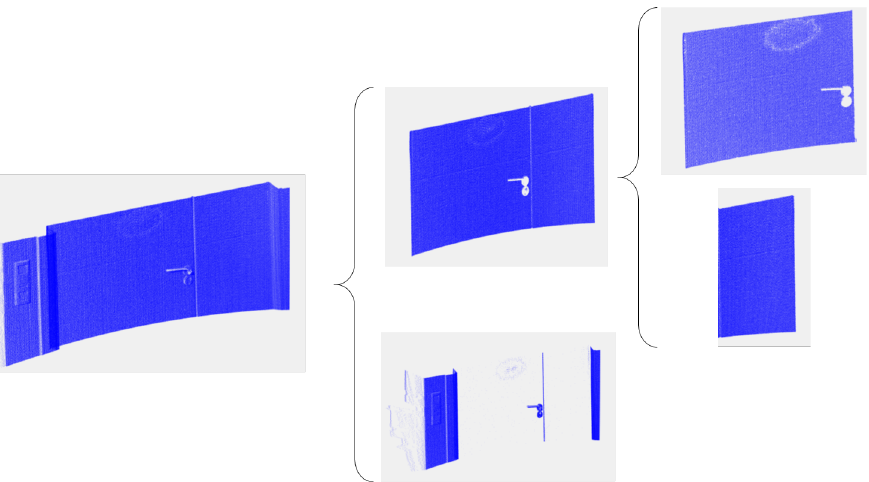
Figure 6. From left to right: the slice of the point cloud taken in front of the door, point clouds fitted to planes π 1 and π 2 and the point clouds of the moving and unmoving